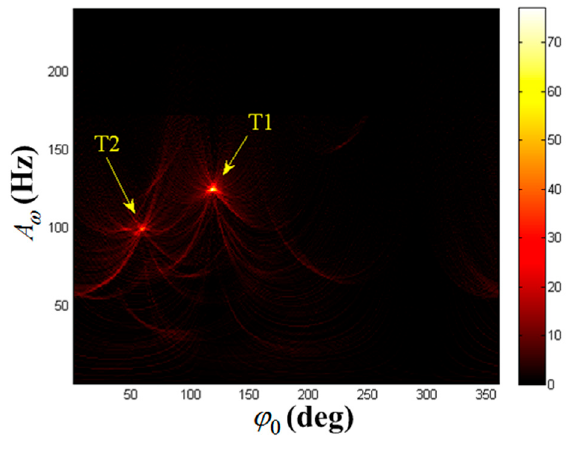
Figure 10. Detection result in